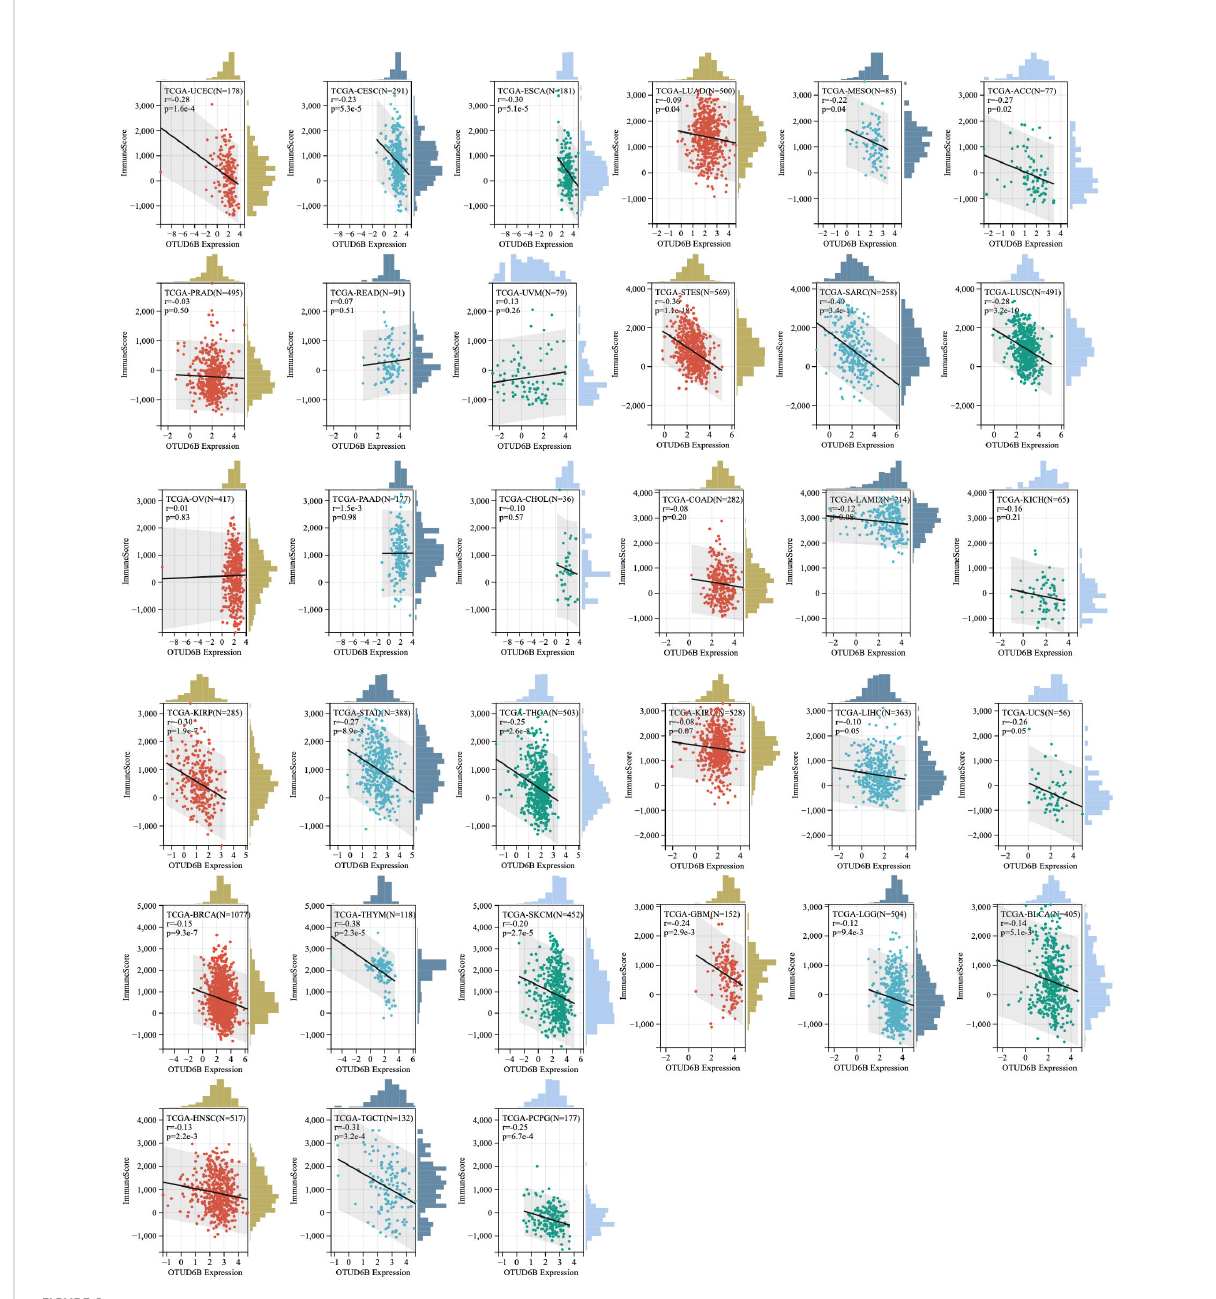
FIGURE 8 Association of OTUD6B expression level with immune score across different types of